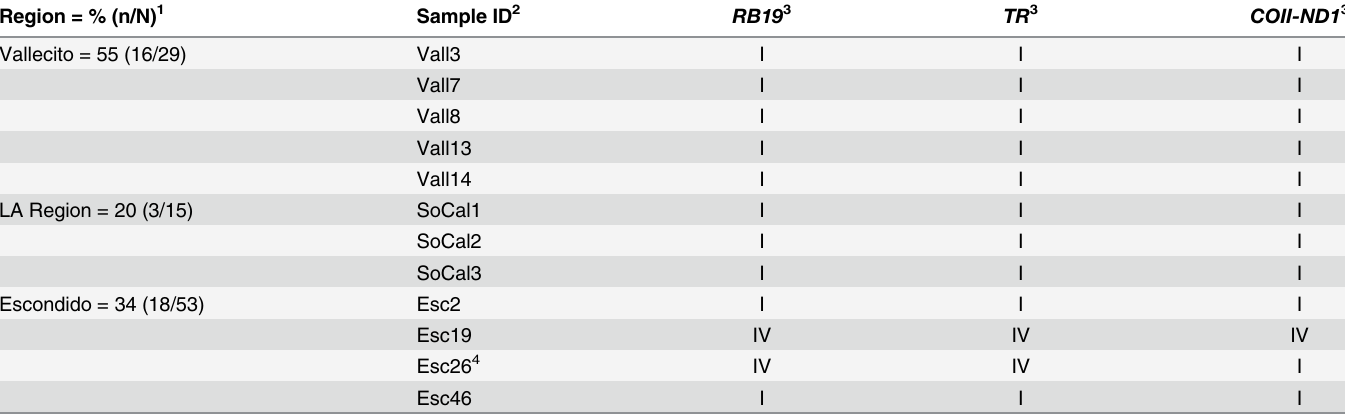
Table 2. Trypanosoma cruzi results for Triatoma protracta specimens. Represented are screening results for all samples tested and discrete typing units (I or IV) for a subset of specimens from each geographic region, based on phylogenetic